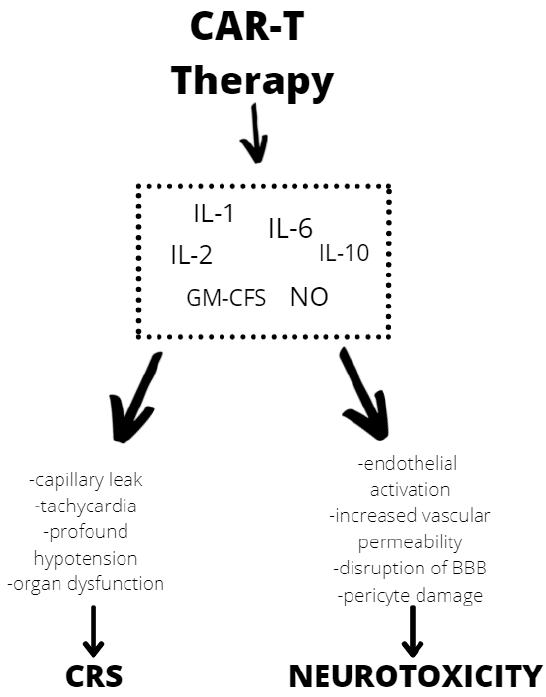
Figure 2. Mechanisms of neurotoxicity and cytokine release syndrome (CRS) caused by CAR T therapy. BBB—blood–brain barrier, GM-CFS—granulocyte-macrophage colony stimulating factor, NO—nitric oxide.